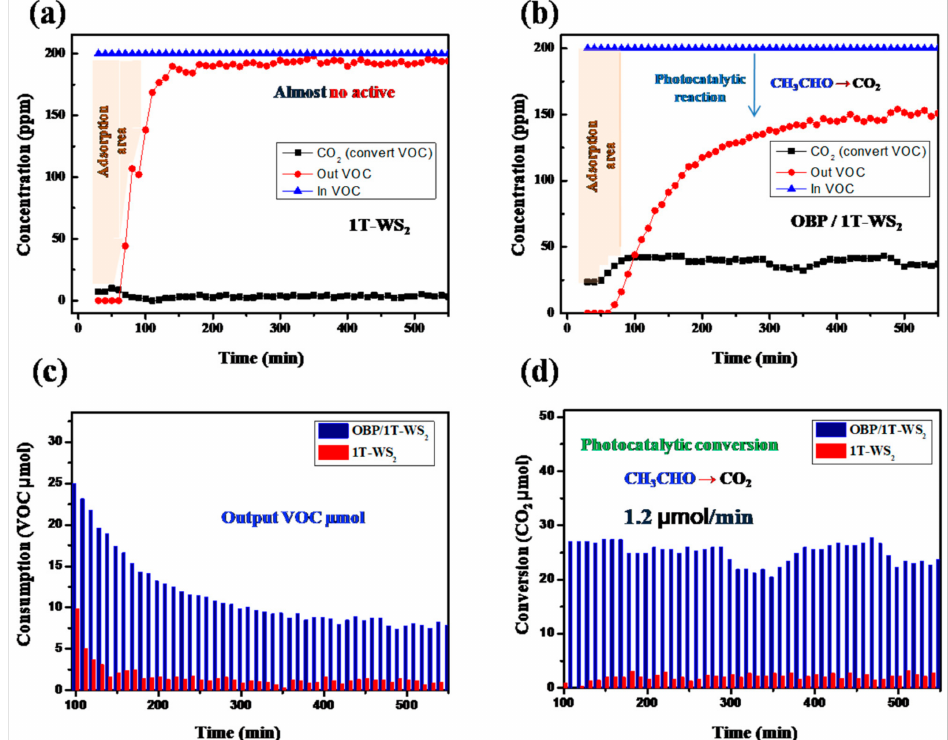
Figure 8. Changes in the amounts of acetaldehyde and CO 2 ppm under 33.6% humidity con- ditions over ( a ) 1T-WS 2 and ( b ) OBP/1T-WS 2 as a function of the 5 W white LED irradia- tion time. ( c ) Acetaldehyde molecule consumption amount for 1T-WS 2 (red) and OBP/1T-WS 2 (navy) according to photocatalytic reaction time. ( d ) Amount converted to CO 2 molecule due to photocatalytic